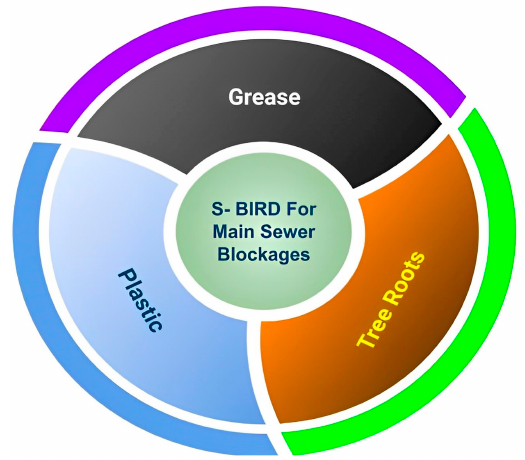
Figure 2. S-BIRD dataset for main sewer blockages.